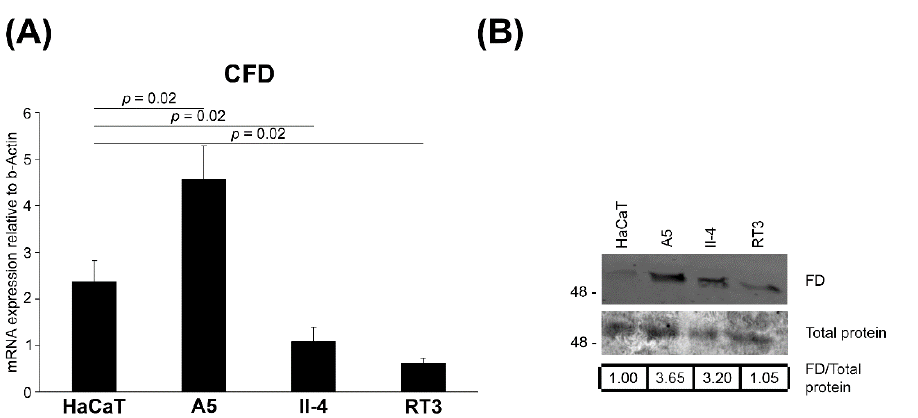
Figure 4. Regulation of FD expression in HaCaT and tumorigenic Ha-ras-Transformed HaCaT cell lines in culture. ( A ), FD mRNA levels were quantified by RT-qPCR in HaCaT cells, a nontumorigenic epidermal keratinocyte-derived cell line and in three Ha-ras-transformed HaCaT cell lines (A5, II-4 and RT3). A5 cells form benign, II-4 cells invasive malignant and RT3 cells metastatic tumors in vivo. The mRNA levels were corrected for levels of β -Actin mRNA in the same samples. Mean ± S.D. are shown; two-tailed t- test. ( B ), The expression of FD protein in conditioned media of HaCaT and Ha-ras-transformed HaCaT cell lines (A5, II-4 and RT3) was determined by Western blot analysis under non-reducing conditions. Equal total protein loading was controlled by Ponceau (0.2%) staining. Migration of molecular weight markers in kDa is shown on the left. Values shown below the Western blots are relative to the levels in HaCaT cells (1.00), The uncropped immunoblot images can be found in Figure S3.